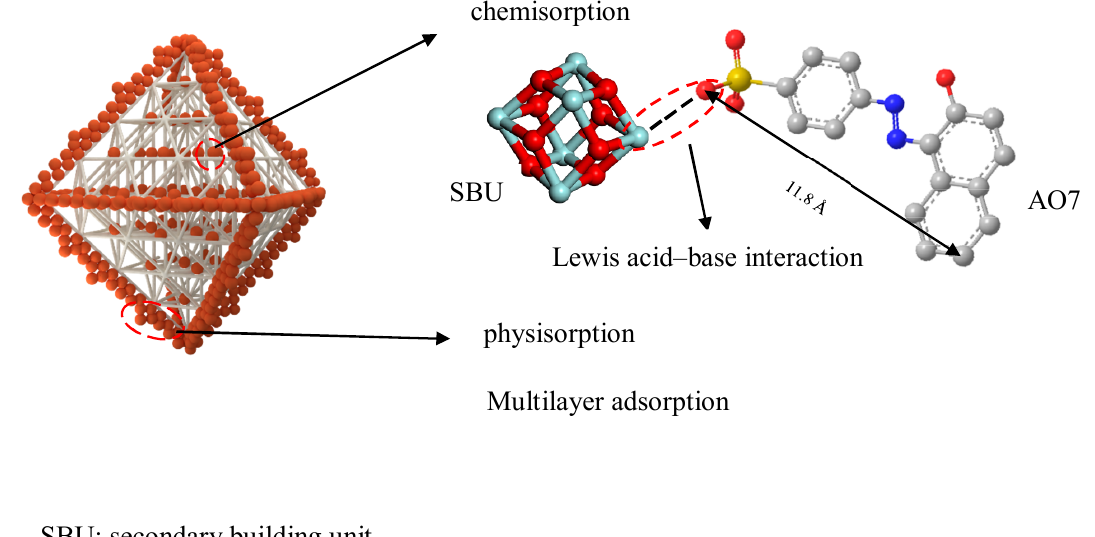
Figure 2. The model of zirconium-based metal-organic frameworks (Zr-MOF) adsorption of acid orange 7 (AO7).